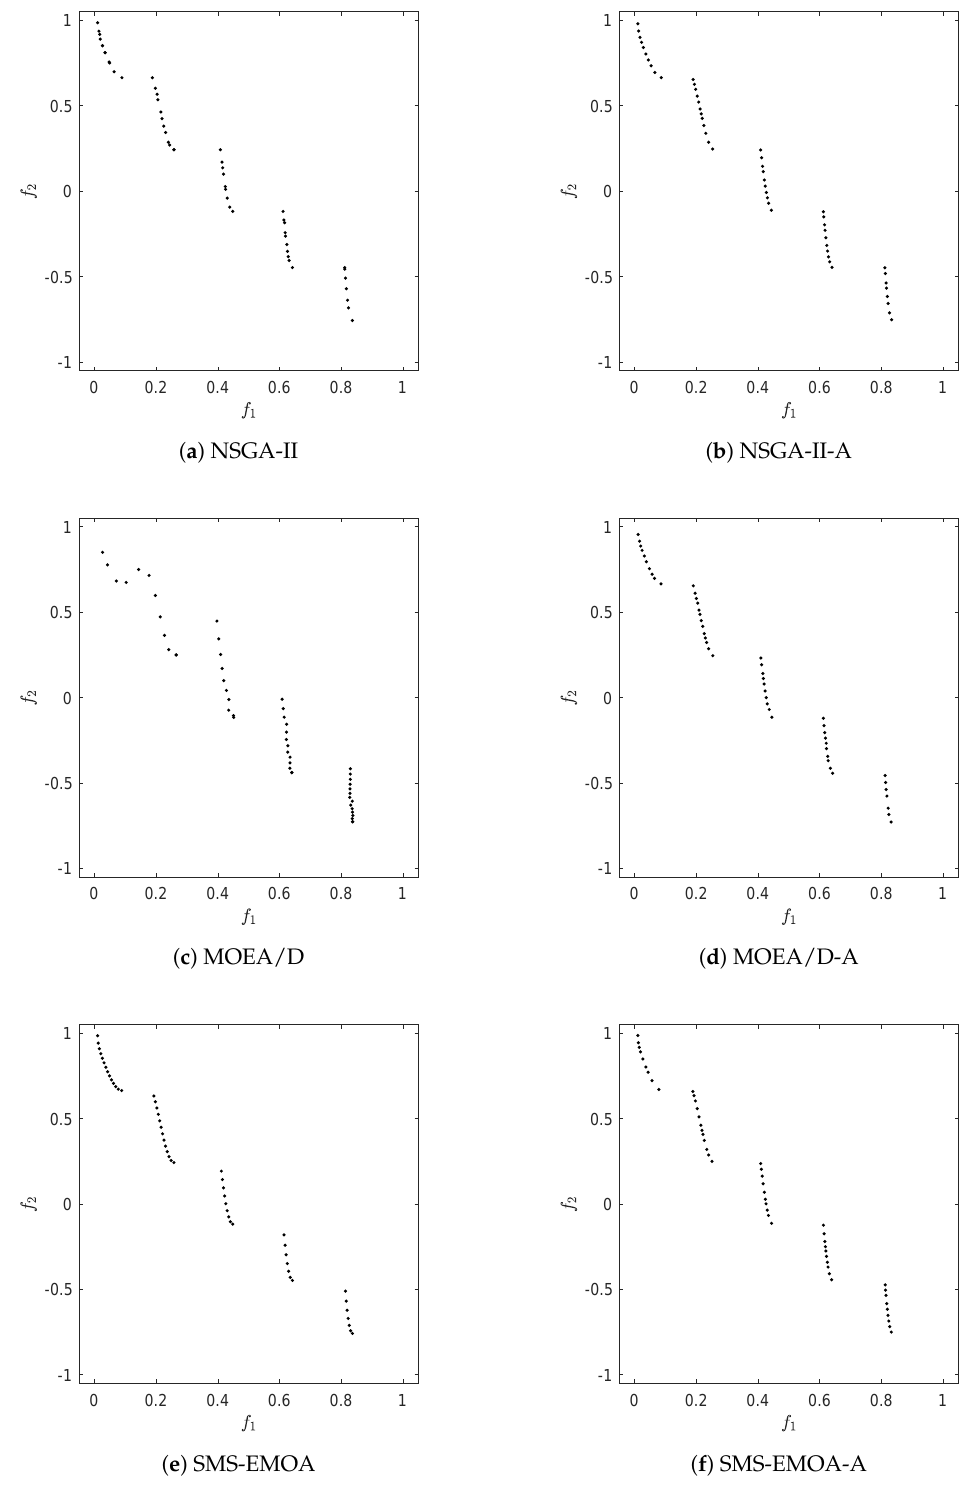
Figure A3. Numerical results of the different algorithms and archiving/selection strategies on